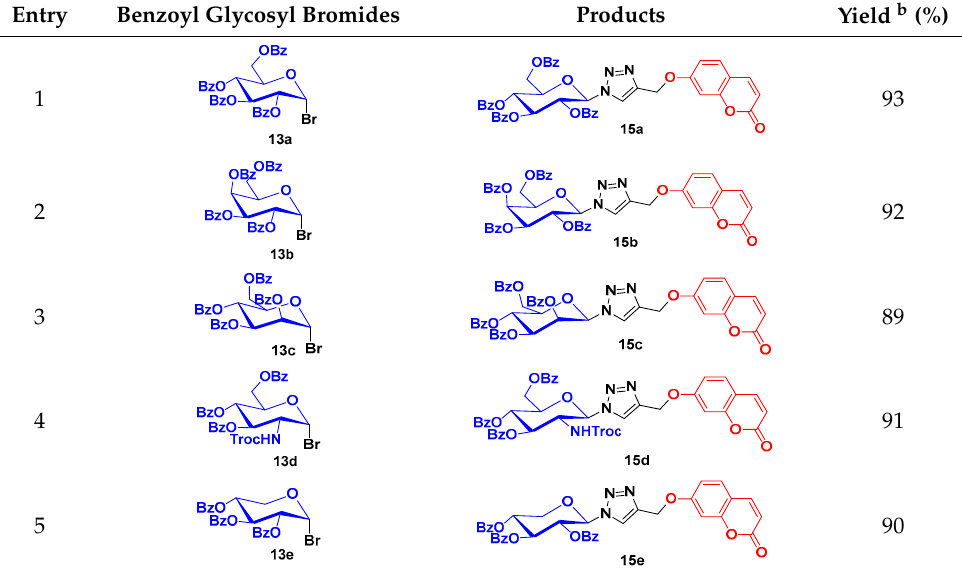
To study the scope of the above reaction, a wide range of diversely benzoyl glycosyl bromides were tried. To our delight, under the conditions mentioned above, two couma- rin-derived alkynes could react smoothly with the in situ generated organic azides from benzoyl glycosyl bromides and NaN 3 to give the corresponding products in excellent yields (Table 2). Table 2. Synthesis of triazoles 15a – 15p using the optimal reaction condition a .